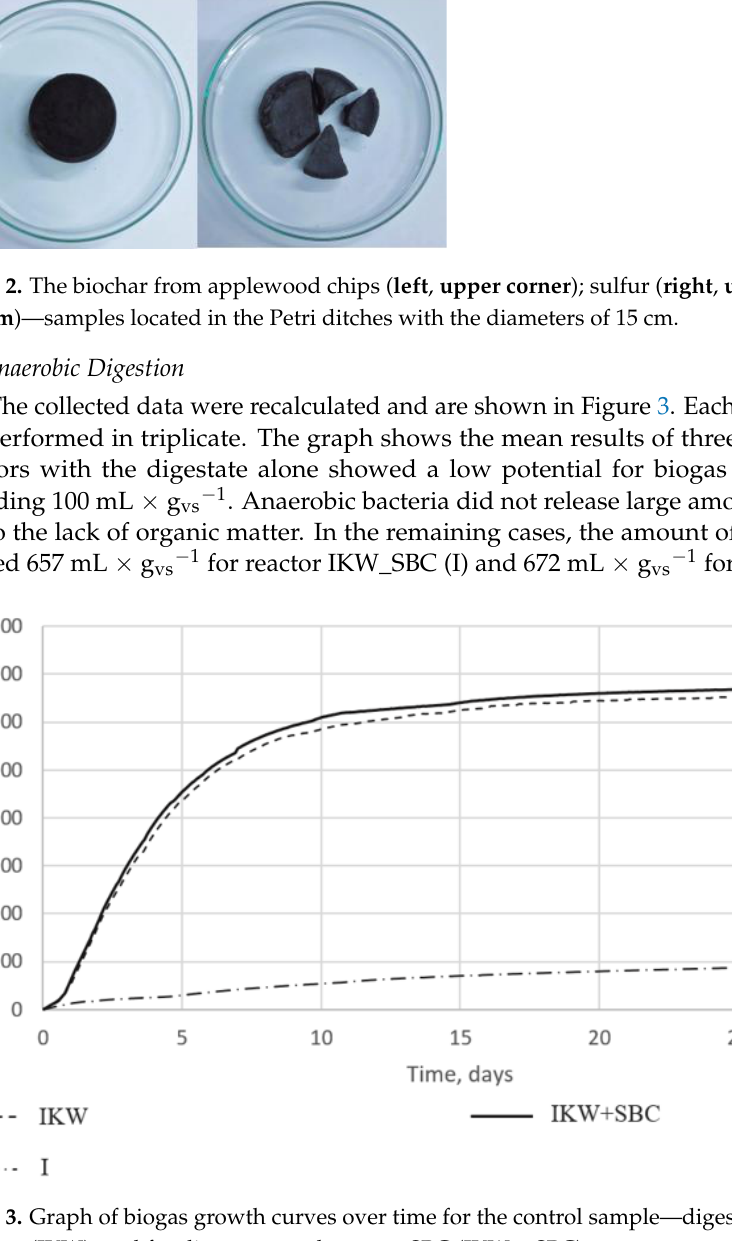
Figure 3. Graph of biogas growth curves over time for the control sample — digestate (I), digestate + substrate (IKW), and for digestate + substrate + SBC (IKW+SBC).